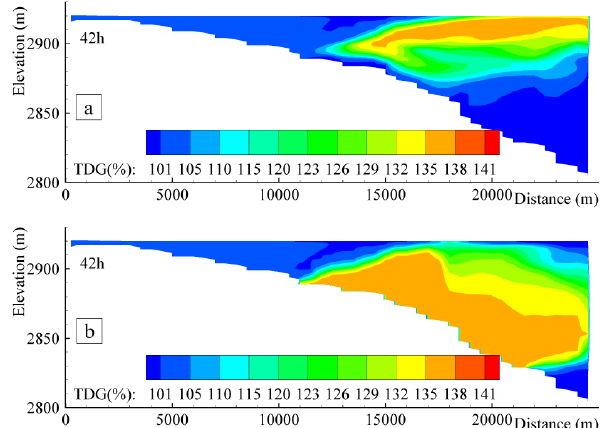
Fig. 13. Accumulated curves of area ratio percent.